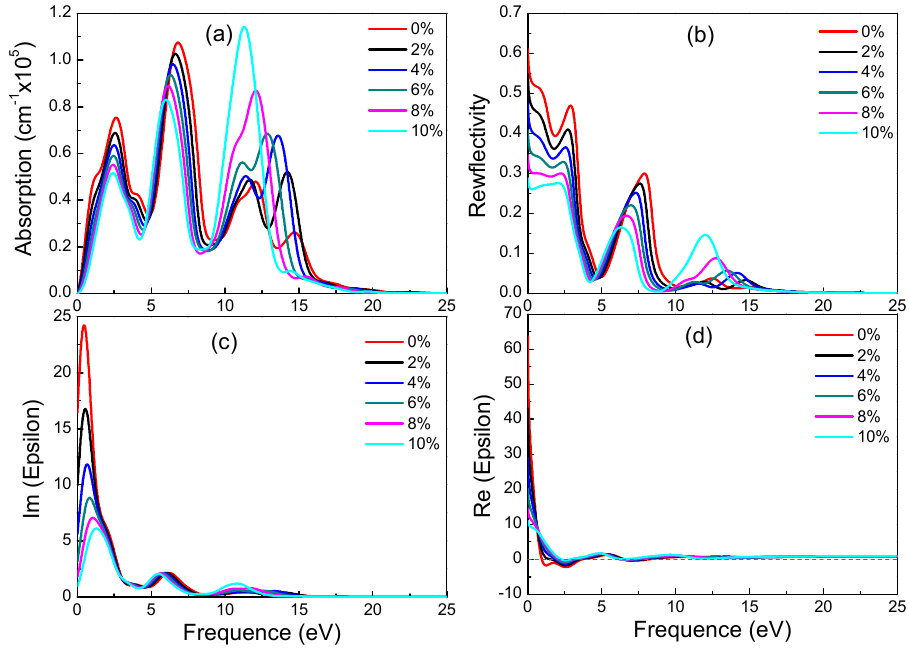
Figure 8. Absorption spectra ( a ), reflectivity ( b ), imaginary ( c ) and real ( d ) part of the dielectric constants of γ -graphyne under different strains. From 0% to 10% strain, combining with electronic structures of α -graphyne, its band gaps remain zero. This phenomenon correlates well with the absorption spectrum. All absorption spectrums increase at 0 eV regardless of the applied strain. In terms of absorption, with the increase of strain,